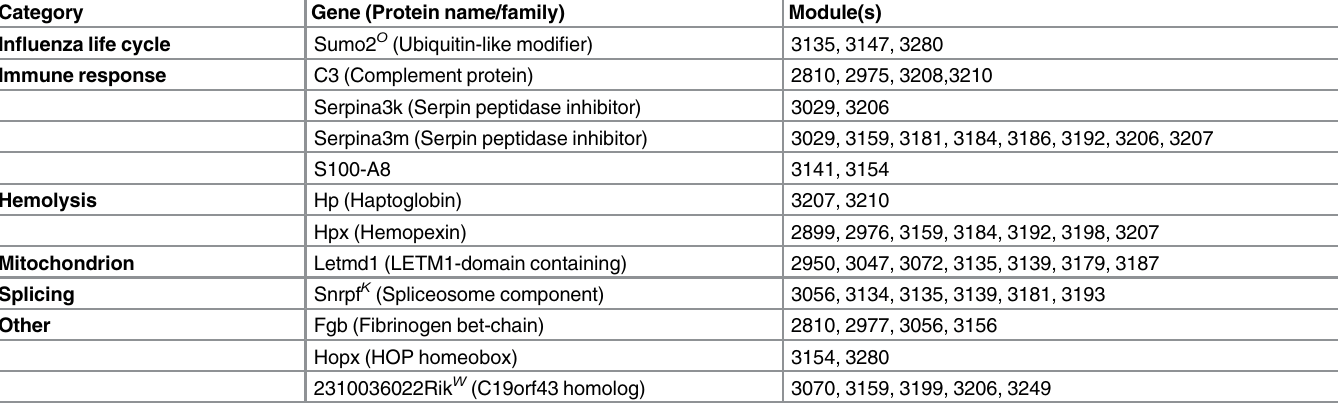
Table 4. Top consensus mouse protein regulators identified by